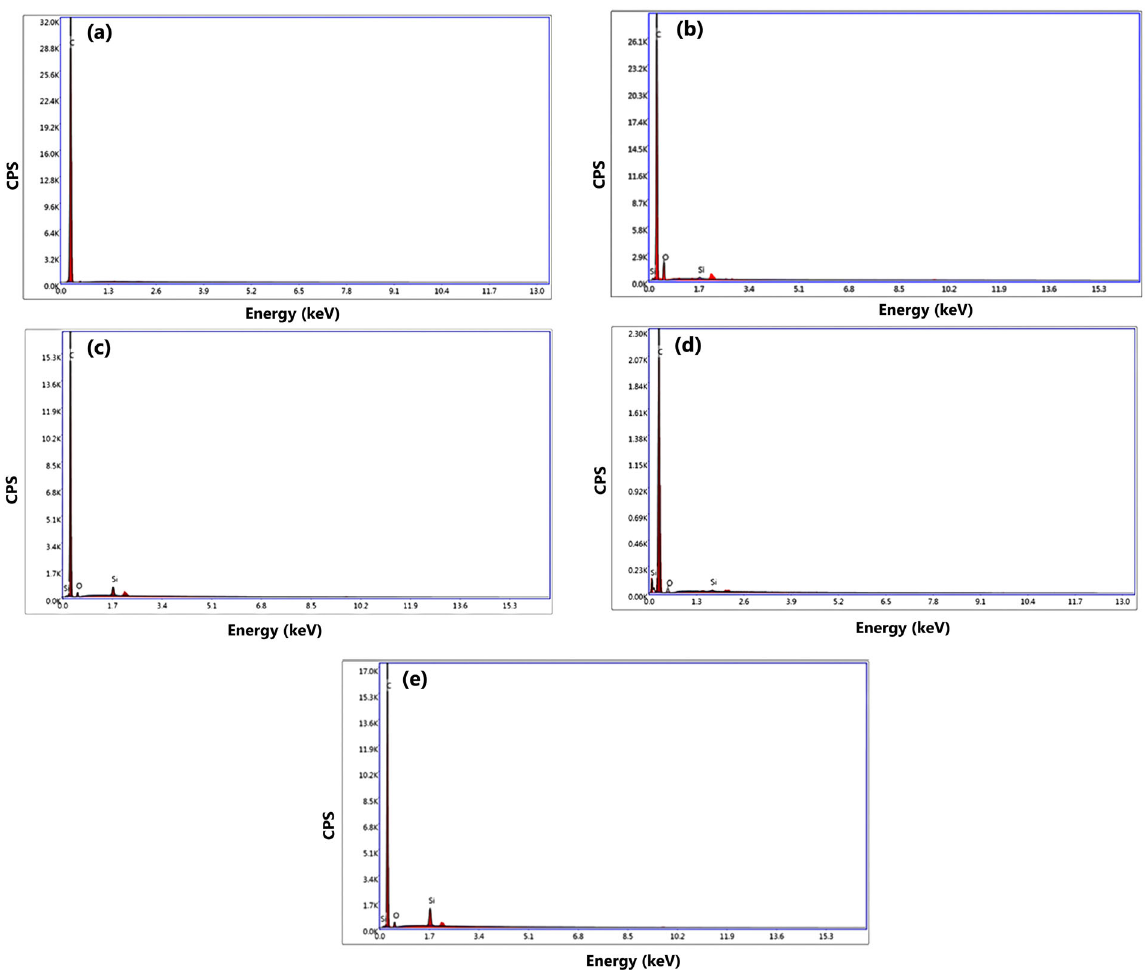
Fig. 3 Energy dispersive X-ray spectrometer analysis of the samples. a Undoped, pure polypropylene. b 0.5% fumed silica-doped polypropylene. c 1% fumed silica-doped polypropylene. d 1.5% fumed silica-doped polypropylene. e 2% fumed silica-doped polypropylene. The amount of silicon in the structure increased from 0.07 to 0.76% as the doping